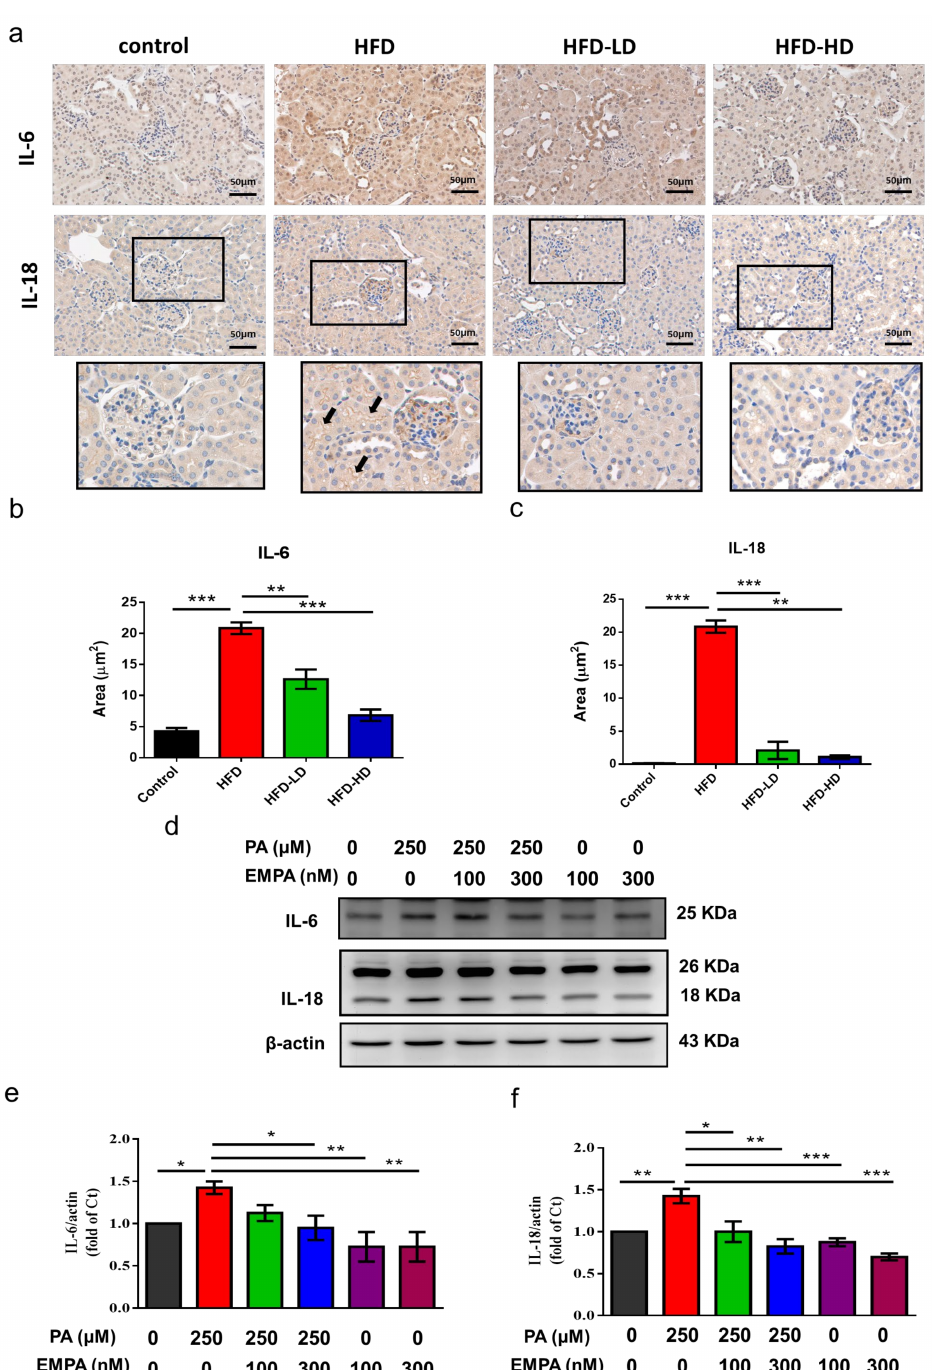
Figure 5. Empagliflozin abolishes HFD- and PA-induced cytokine production in the kidney section and proximal tubular cells. ( a ) HFD increased IL-6 expression in the tubular areas and IL-18 over lumens of tubules (black arrows) and glomerular areas. Both low and high dose of empagliflozin attenuated HFD-induced IL-6 and IL-18 expression. ( b , c ) Quantitative results for immunohistochemistry intensity are shown as mean ± standard error (SE) from six experiments. ( d – f ) HK-2 cells were cultured in medium with 1% bovine serum albumin and PA (250 µ M), with or without low-dose (100 nM) or high-dose (300 nM) empagliflozin. High-dose empagliflozin attenuates PA-related upregulation of inflammatory cytokines IL-6 and IL-18. Statistical analysis was performed with one-way ANOVA. * p < 0.05, ** p < 0.01, *** p < 0.001. PA, palmitic acid; EMPA,